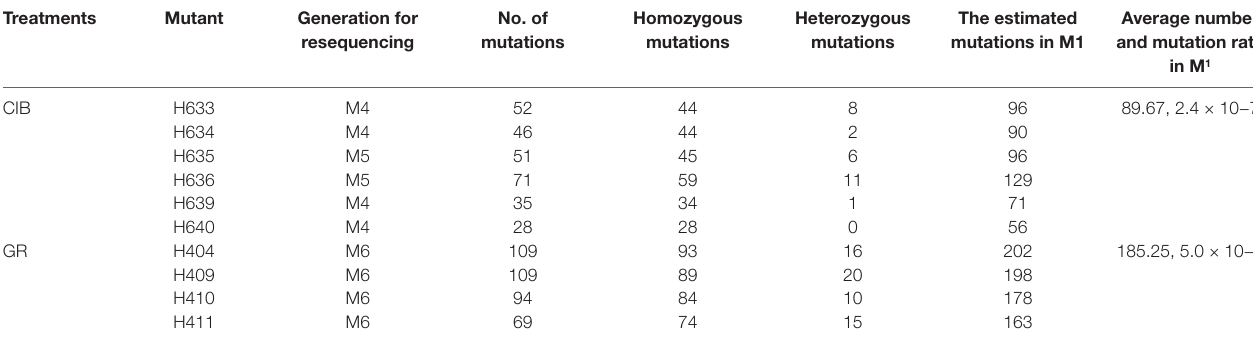
TaBLe 3 | Estimated numbers of mutations and mutation rate in M1 plants. Treatments Mutant